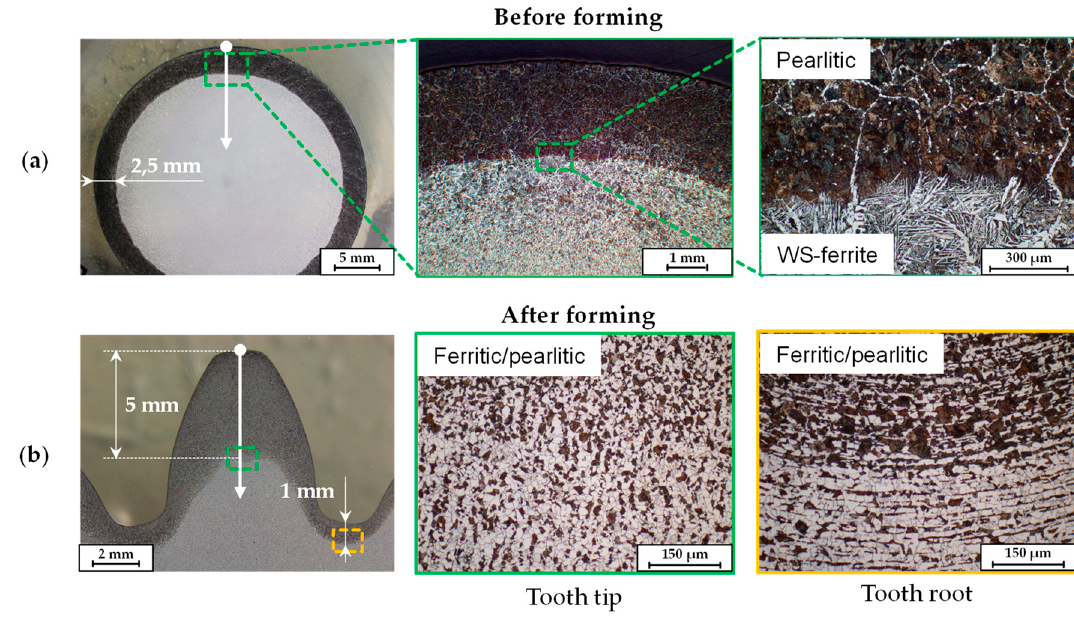
Figure 6. Macro- and micrographs of the joining zone in cross section in a deposition-welded workpiece ( a ) and in a forged bevel gear ( b ).